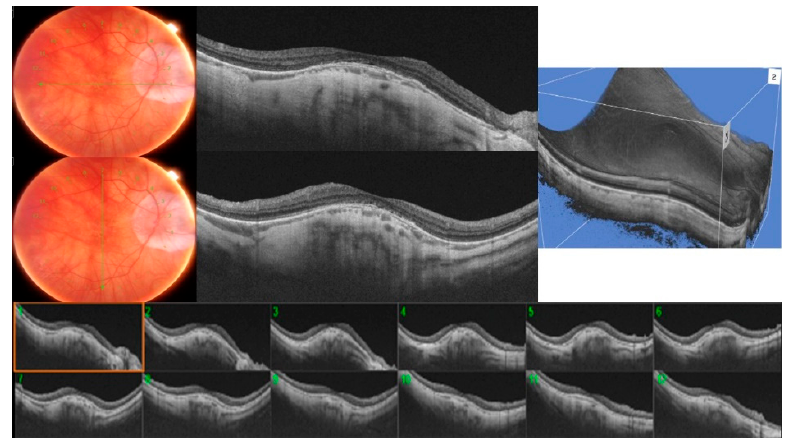
Figure 2. A typical round dome ‐ shaped macula (DSM) with the 12 radial OCT scans centered on the fovea showing an inward convexity of ≥ 50 μ m.